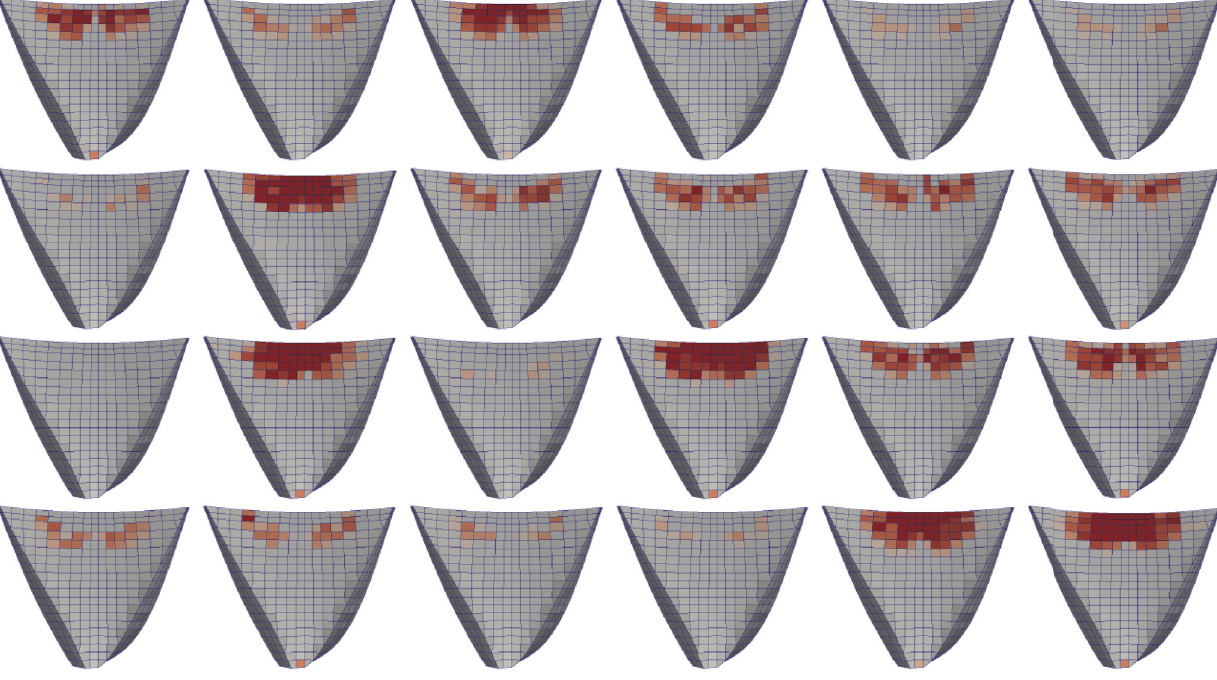
Figure 11: Distribution of third crack on downstream face; top left: Sim-1; first row: 1 to 6; bottom right: